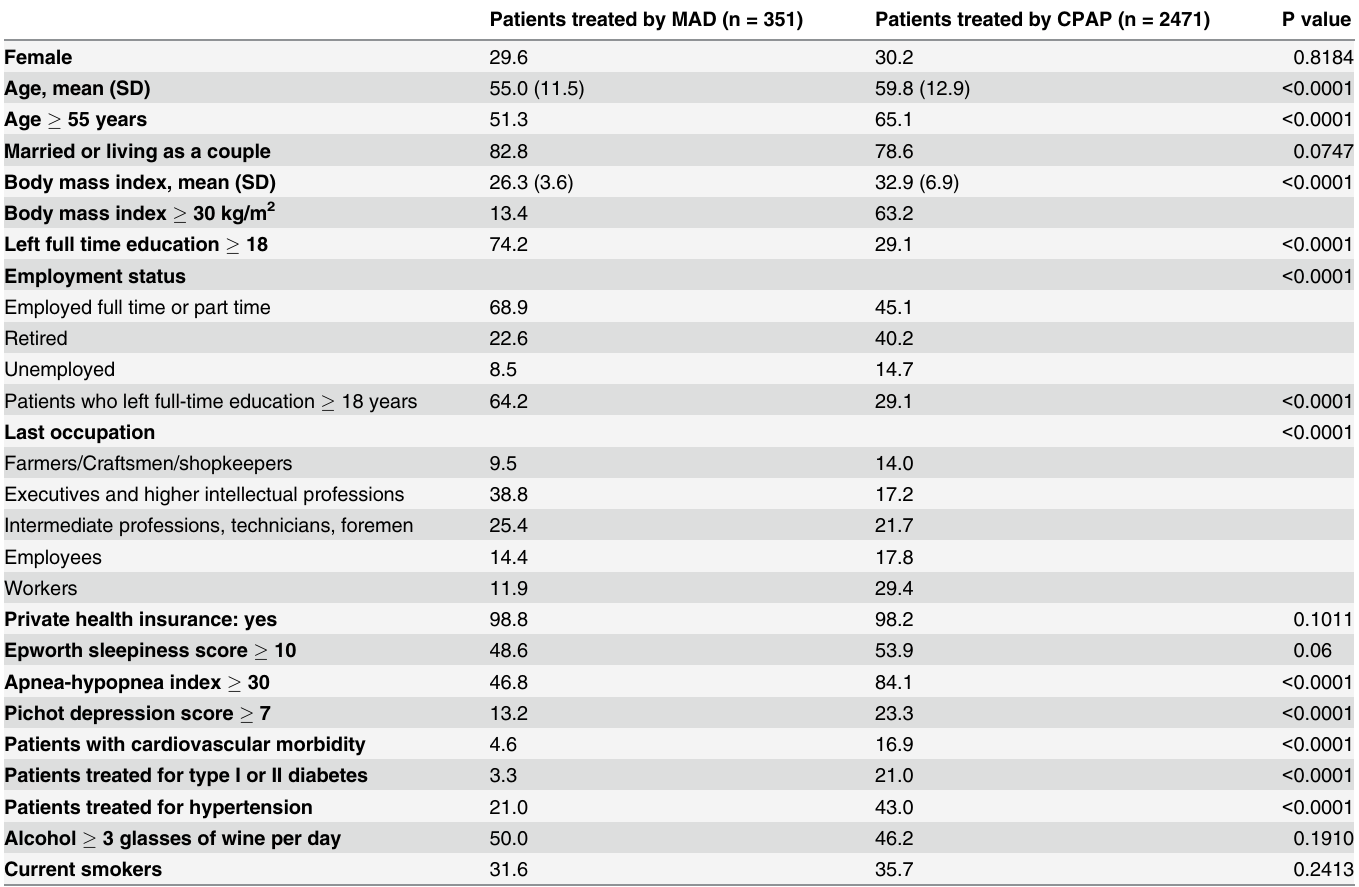
Table 1. Baseline characteristics of patients treated by MAD and patients treated by CPAP. Results are presented as percentages unless otherwise indicated. Significant level for p value: <